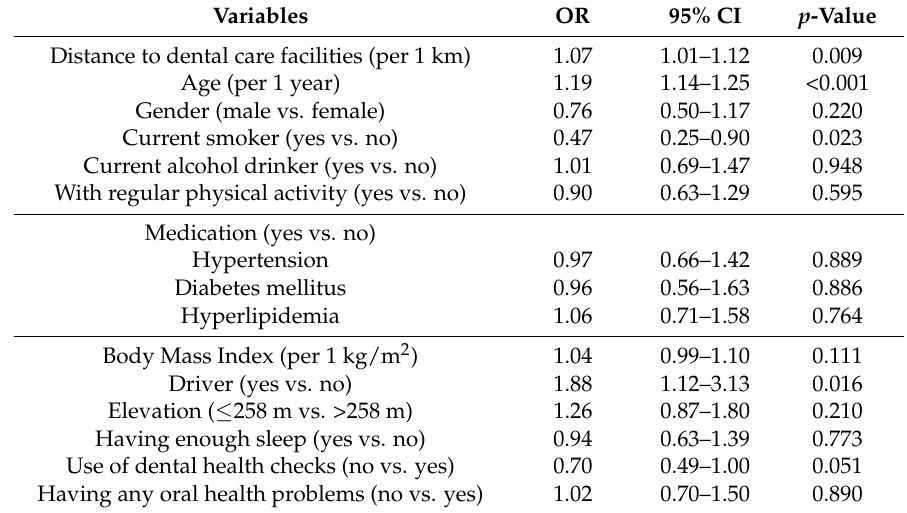
Table 2. Multivariable logistic regression analysis with the number of teeth as the dependent